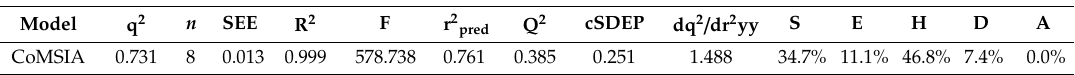
Table 2. Evaluation parameters of the comparative molecular similarity index analysis (CoMSIA) model for the biodegradability of the PAEs by three plasticizer-degrading bacteria.